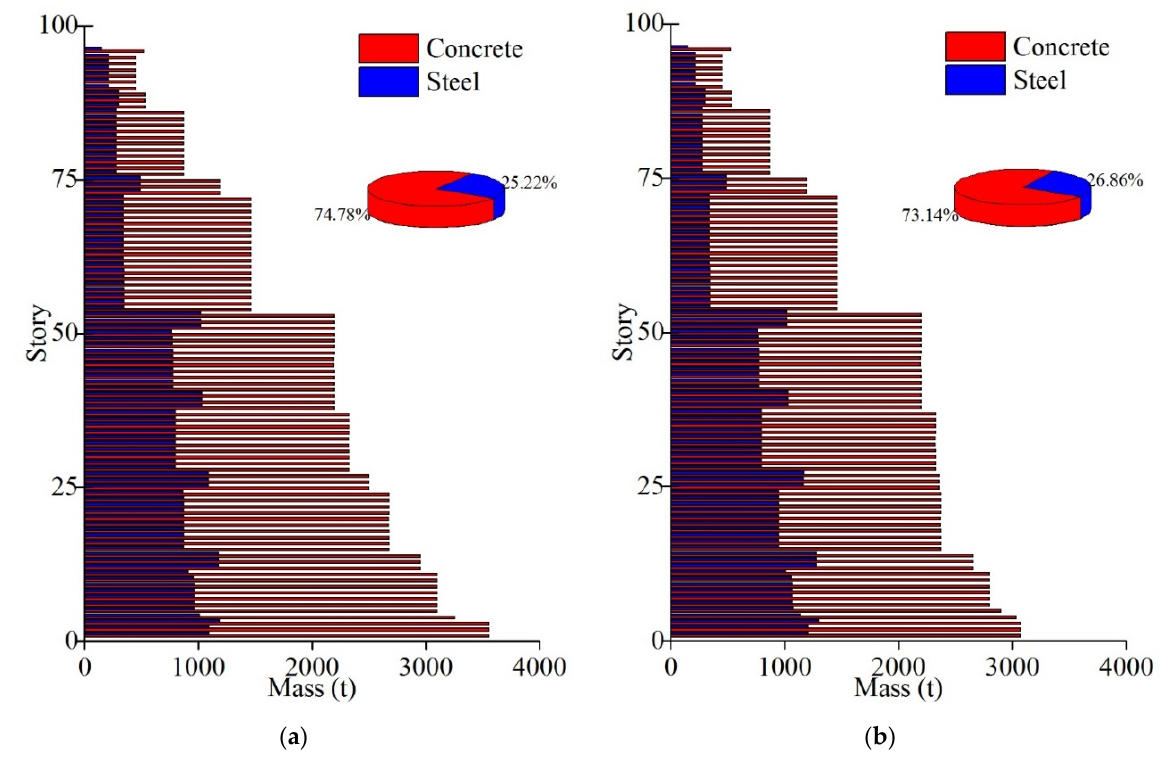
Figure 23. Comparison of material consumption: ( a ) RC models; ( b ) GSPCW models. Table 8. Statistics of material mass and available area.